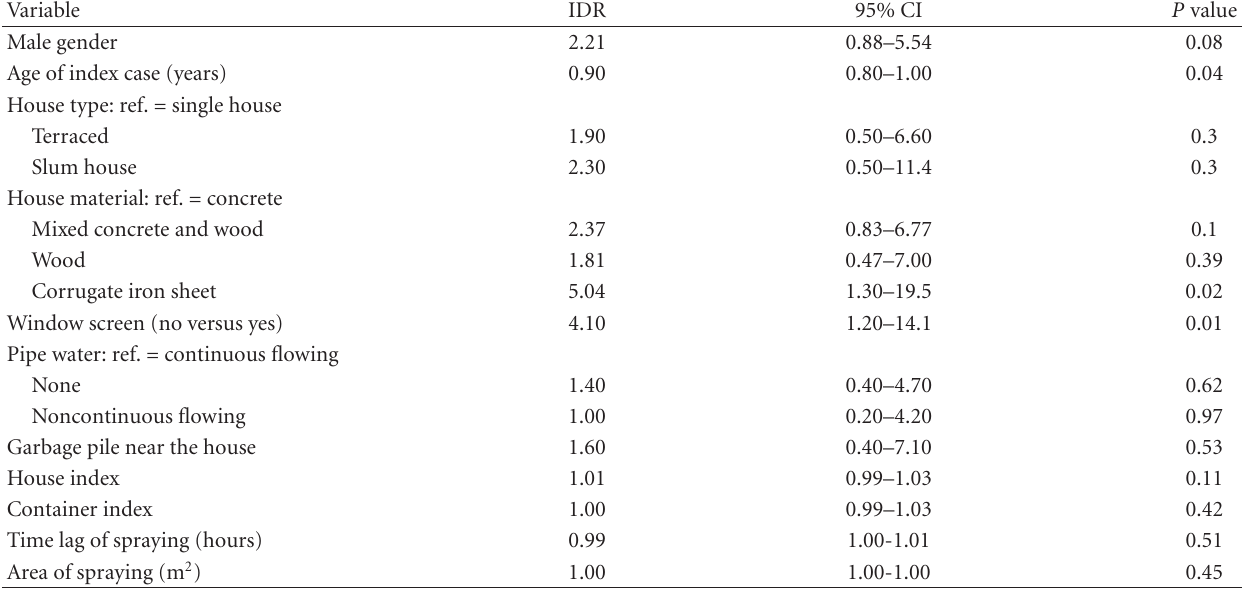
Table 5: Univariate analysis of factors a ff ecting incidence of secondary DF/DHF.